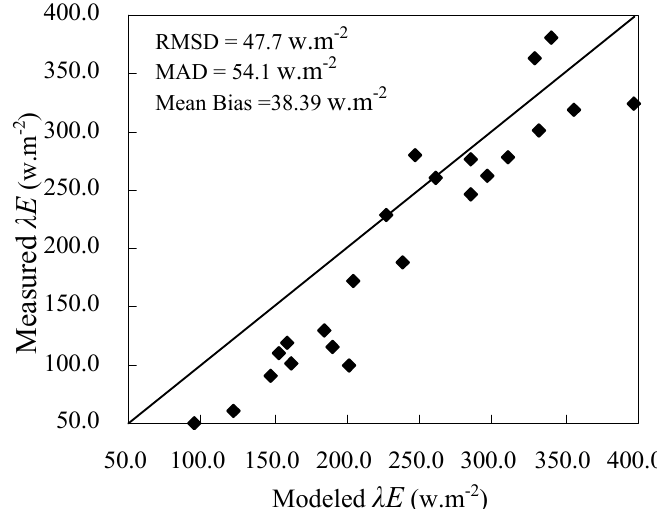
Figure 6. Modeled versus measured latent heat flux, λ E . The line represents a 1: 1